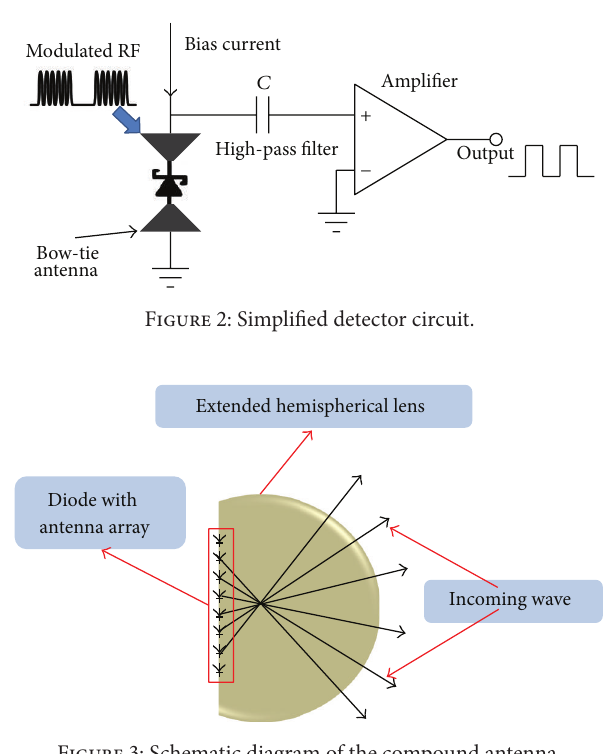
Figure 3: Schematic diagram of the compound